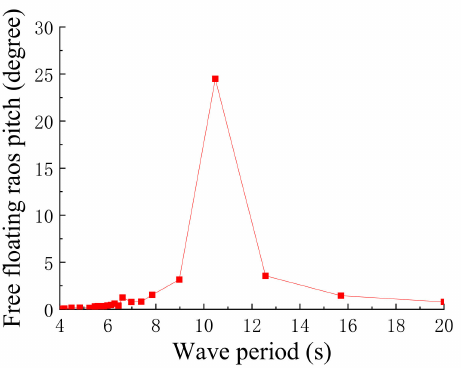
Figure 4. Pitch RAO of the free wave energy converters (WEC) module.